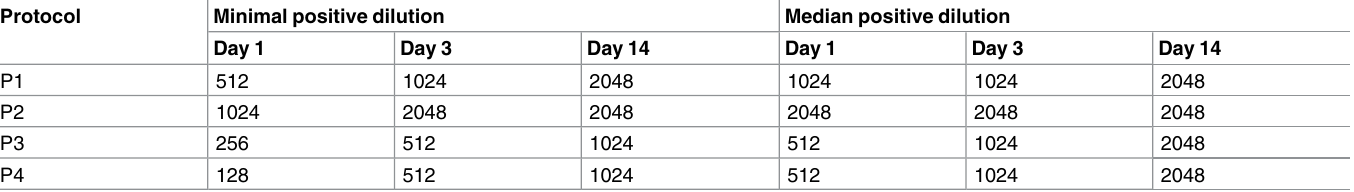
Table 3. Minimal and median positive dilution levels obtained of five reference samples for each protocol and day of testing.